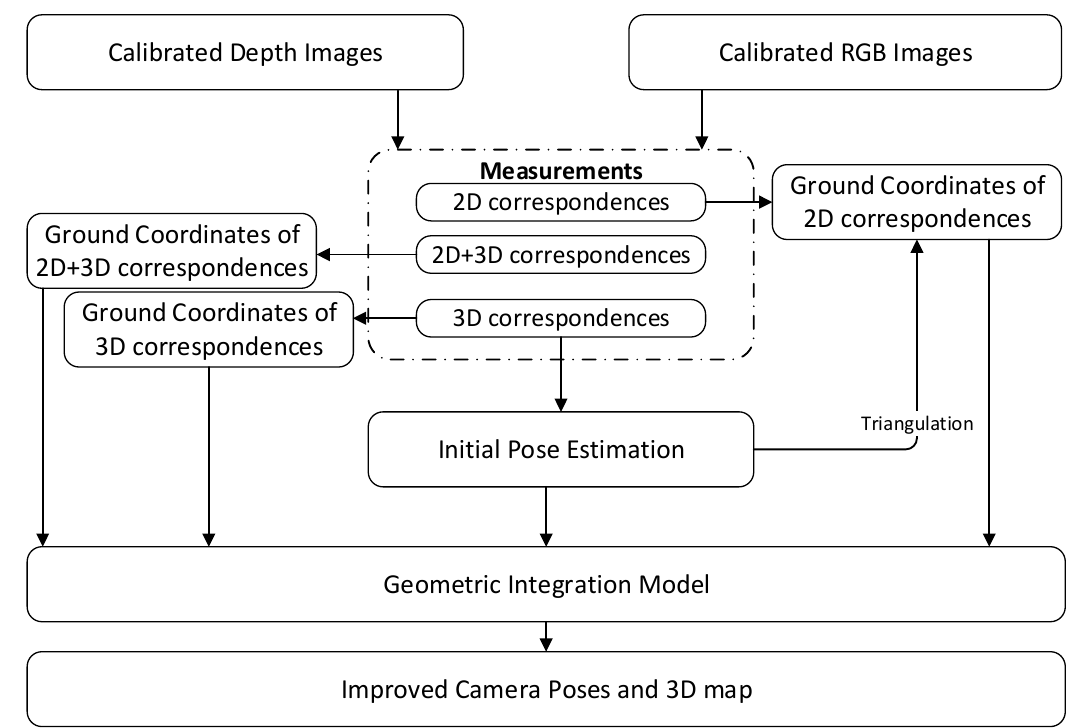
Figure 1. Framework of the geometric integration approach.